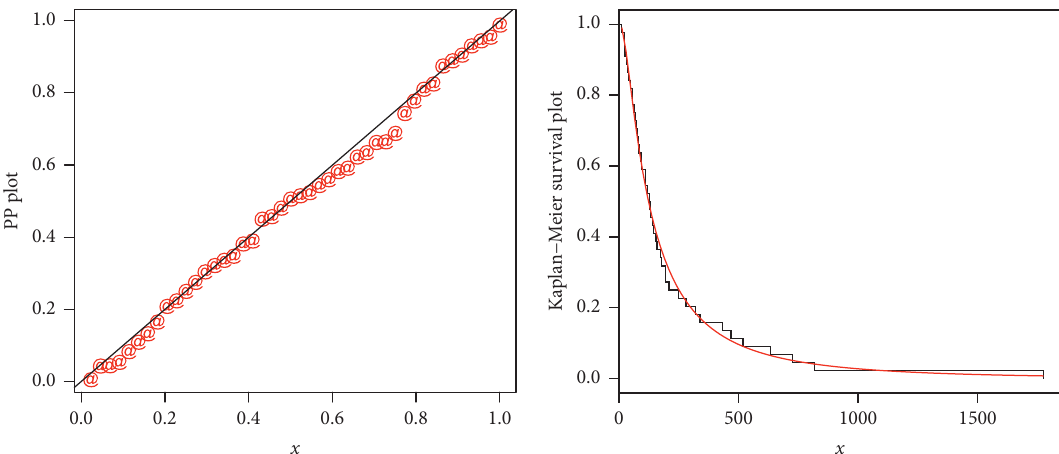
Figure 6: PP and Kaplan–Meier survival plots of the NE-W distribution for data